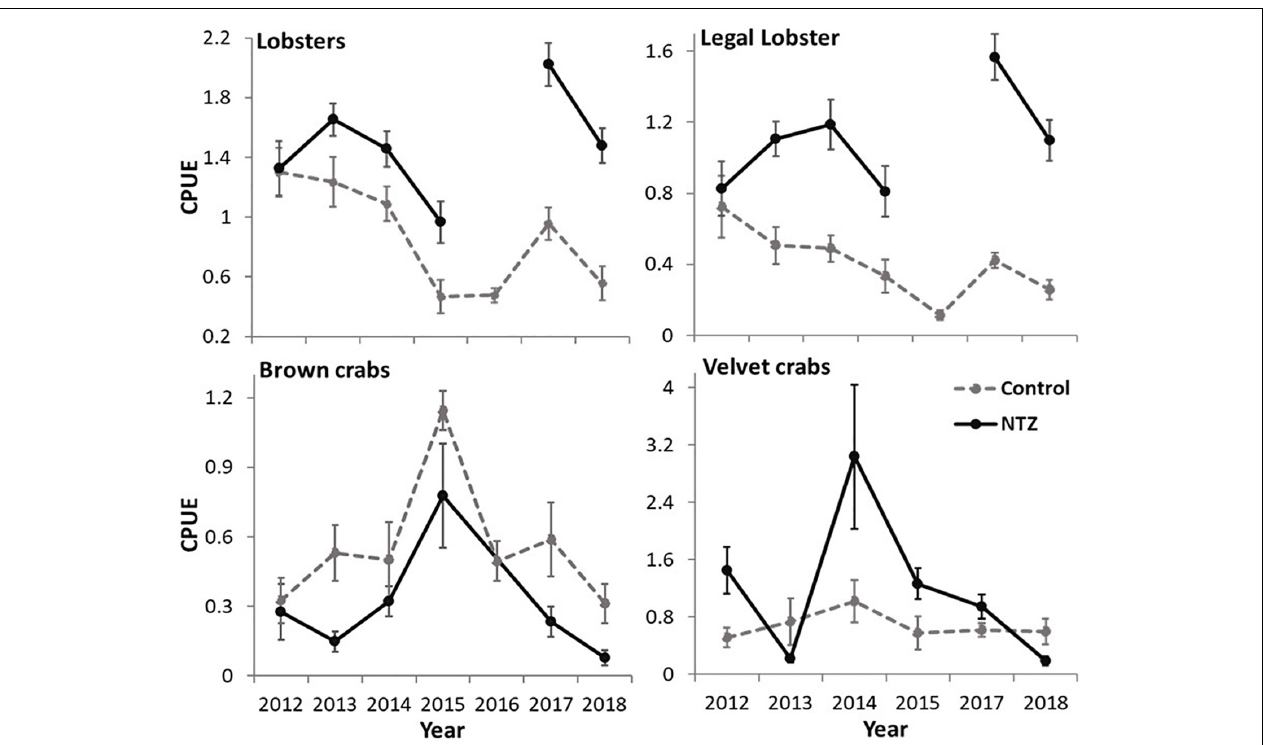
FIGURE 7 | Mean catch per unit effort CPUE (y-axis) of lobsters, legal-sized lobsters ( > 88 mm carapace length), brown crab, and velvet swimming crabs within the NTZ and control sites in the surrounding fishing grounds over the 6-year study period (2012–2018). Black lines represents the NTZ and gray lines the control sites. Error bars represent ± 1 SE. There is no data for the NTZ in 2016 because it was not surveyed that